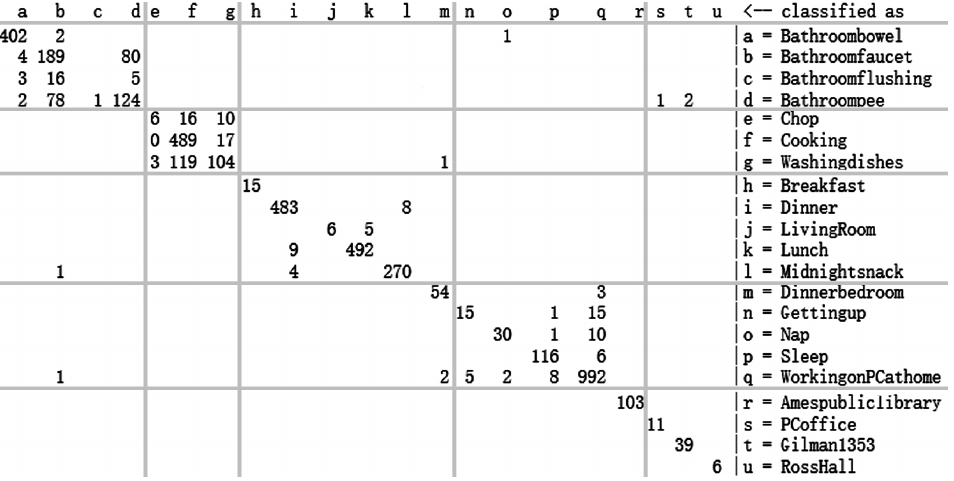
Figure 9. Confusion matrix for 21 scenes classified using Bayesian